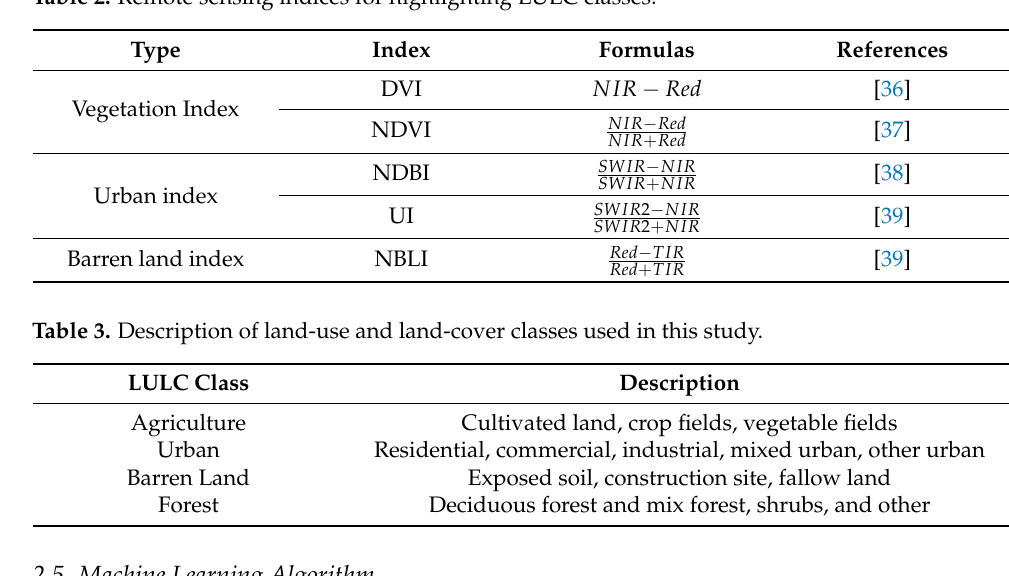
Table 2. Remote sensing indices for highlighting LULC classes.